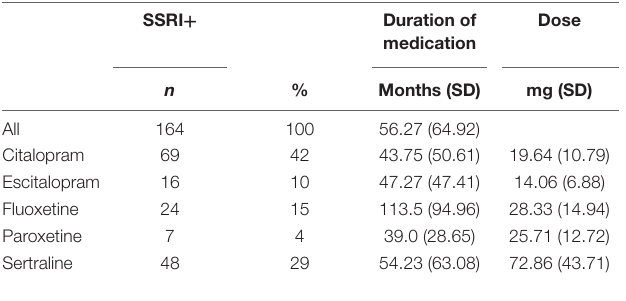
TABLE 1 | Selective serotonin reuptake inhibitor (SSRI) treatment. SSRI